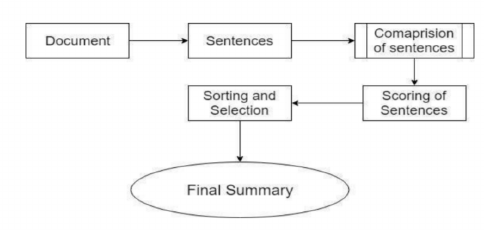
Figure 3. Extractive Summarization